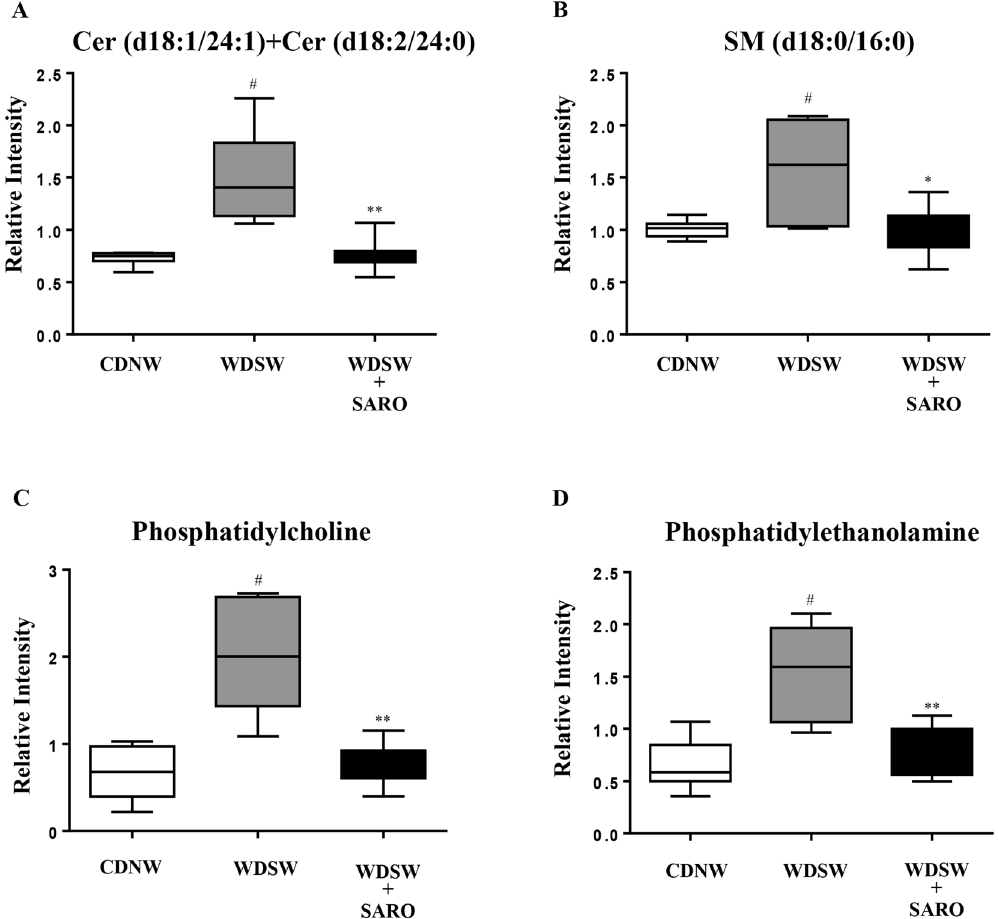
Figure 8. Saroglitazar treatment reduces lipotoxic compounds in the liver. Endogenous metabolic profiles of liver samples taken from mice fed with CDNW or WDSW treated with/without saroglitazar were determined using ultra high performance liquid chromatography- mass spectrometry (UHPLC-MS). Box plots of ( A ) ceramide, ( B ) sphingomyelin, ( C ) phosphatidylcholine, ( D ) phosphatidylethanolamine. Data are expressed as the mean ± SEM for 6–12 mice per group. # p < 0.05, ## p < 0.001 compared to CDNW; * p < 0.05, ** p < 0.001 compared to WDSW, vehicle